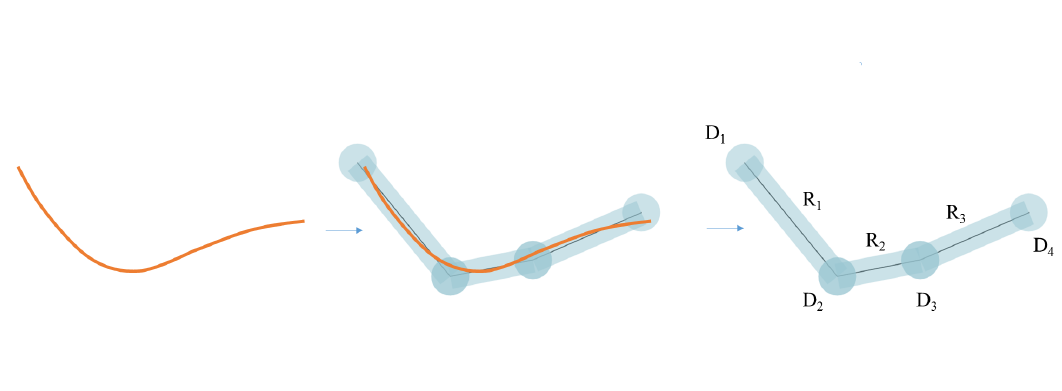
Figure 9. Trajectory region obtained by the iteration of the map F b , d , with δ = 0.075 and (cid:101) δ = 0.1, for the dimensions of the rectangular regions and disks respectively. On the left an example of an eventual real trajectory and in the middle the trajectory fitted into the pure bimodal trajectory region.